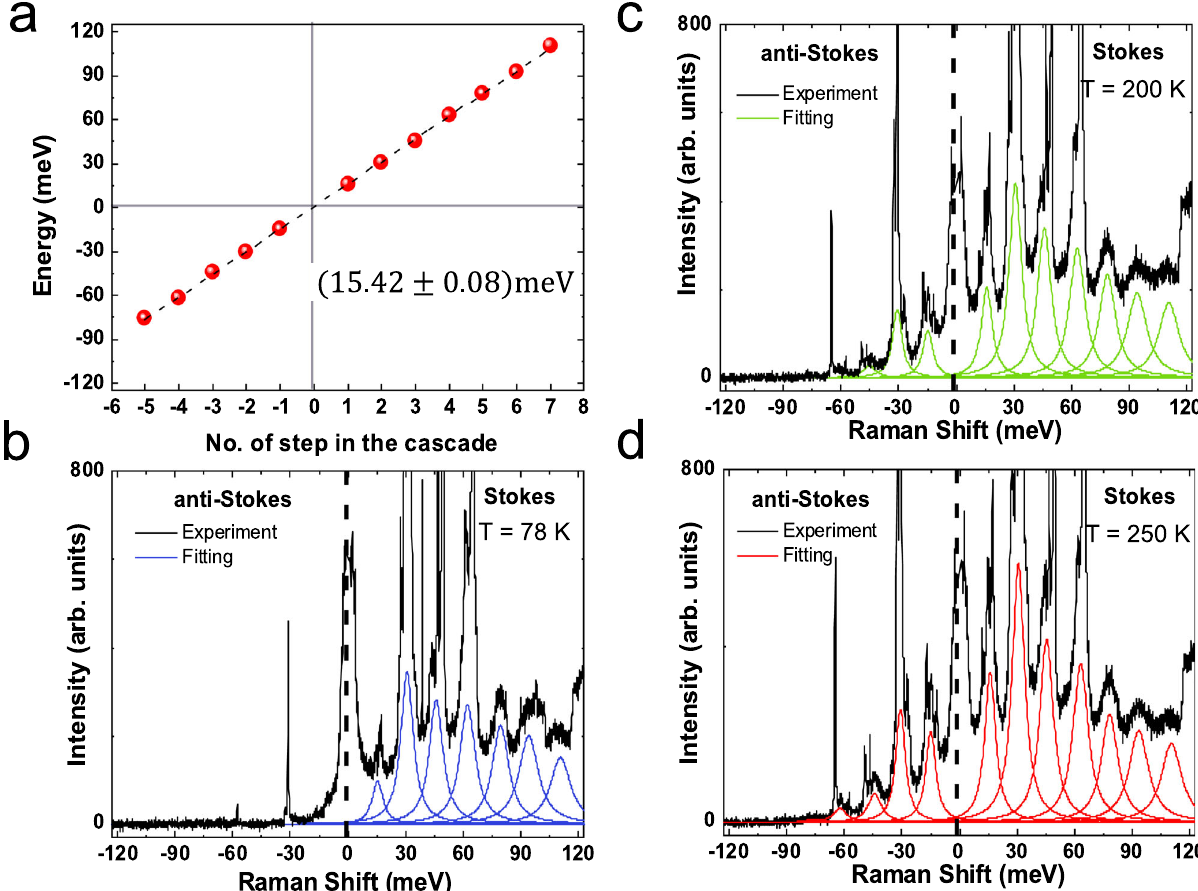
Fig. 2 Energy separation and T dependence. a Emission energies as a function of number of steps in the cascade, extracted from the RT spectrum in Fig. 1b. The dashed black line is a linear fi t, giving a step energy ~15.42 ± 0.08meV. b – d 532 nm Hot PL spectra of 1L-WSe 2 at b 78 K, c 200 K, d 250